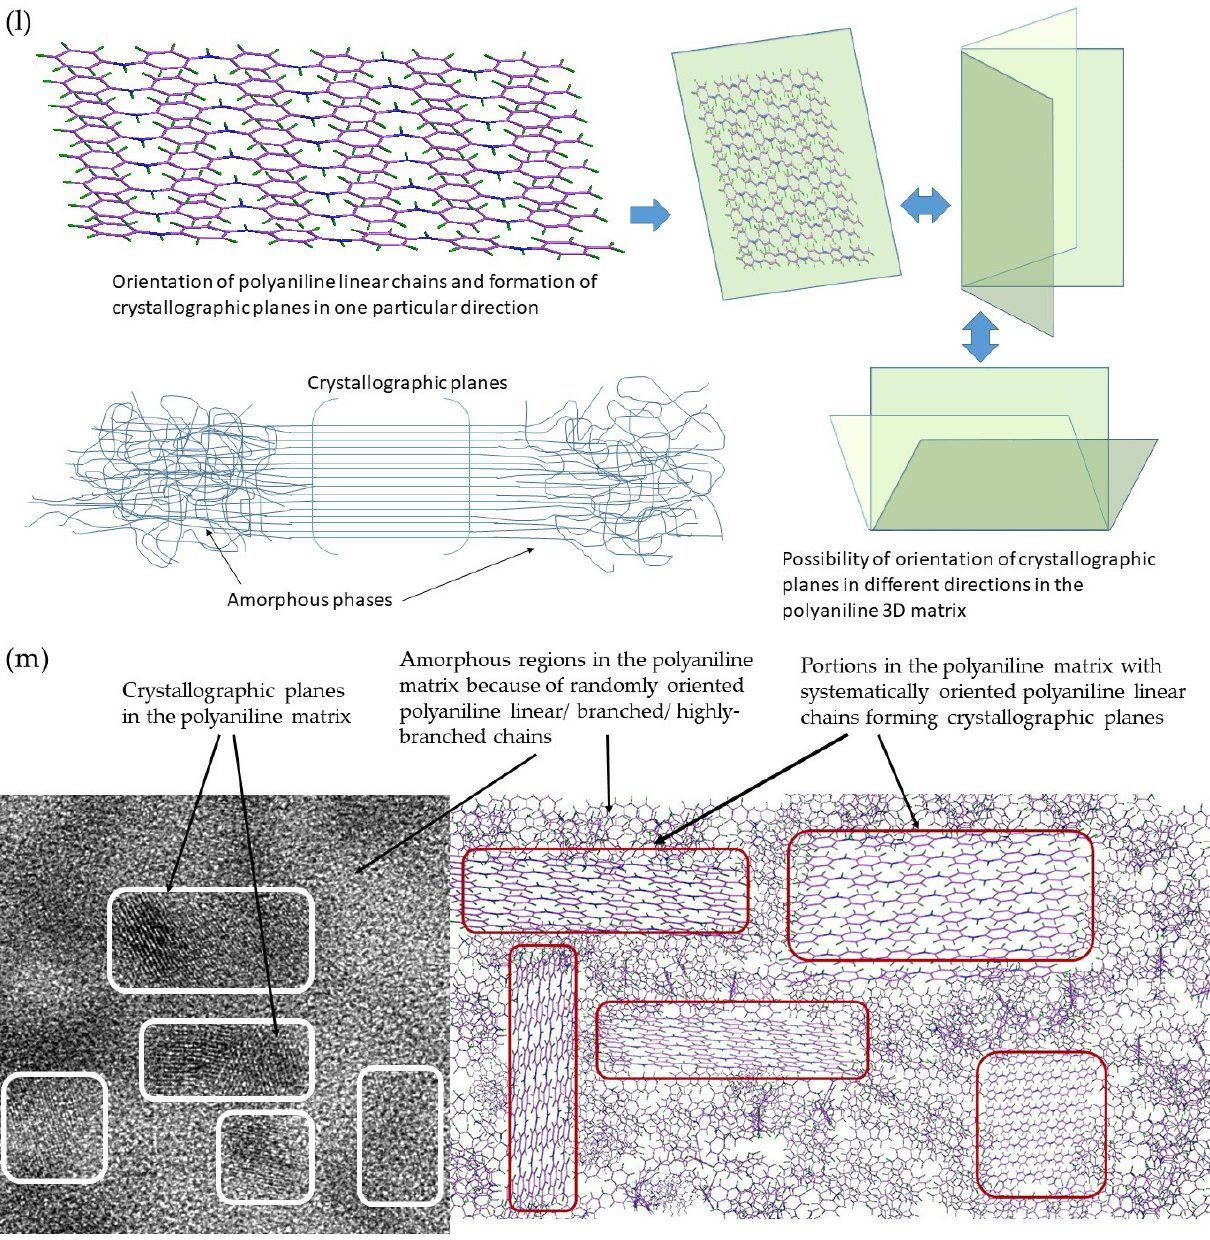
Figure 8. Sequence of events probably taking place during the chemical oxidative polymerization of aniline in the presence of S 2 O 82 − (ammonium peroxydisulfate). ( a – d ) A twisted polyaniline chain with 18 monomer units not geometrically stabilized by p π –p π orbital overlap. Long and linear chains of polyaniline are highly likely to be interwoven with other neighboring linear chains, nucleates (short trimers) or polyaniline chains of relatively shorter lengths and give rise to the amorphous phase. ( e – h ) Planar geometry of the linear polyaniline chain conducive of initiating interactions between the p π –p π orbital lobes and stabilizing the overlap of the same. ( i – k ) A large collection of well-arranged linear polyaniline chains with stabilized geometry giving rise to the crystalline lattice. ( l , m ) Different orientations of the crystalline lattices and amorphous phases in the polyaniline matrix as it appears in the HRTEM image.